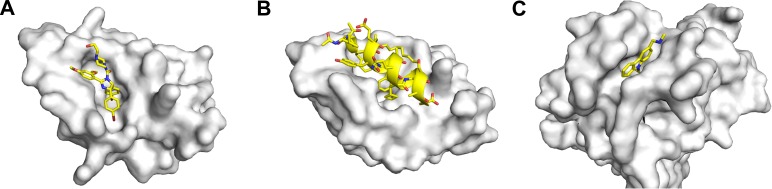
Structures of molecules developed to modulate the p53 pathway. (A) Nutlin-2 in complex with MDM2 (PDB 1RV1) (Vassilev et al., 2004). (B) ATSP-7041 in complex with MDMX (PDB 4N5T) (Chang et al., 2013). (C) PhiKan083 in complex with p53 DBD (PDB 2VUK) (Boeckler et al., 2008).